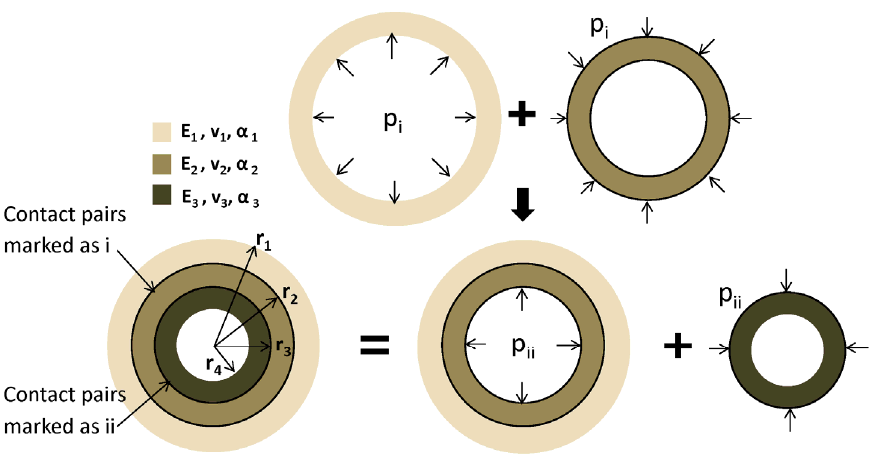
Figure 6. Superposition principle of tri-layer thick-walled cylinders installed from outside to inside.